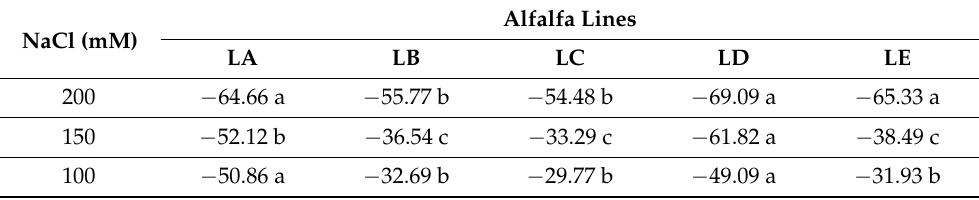
Table 1. Indexes of salt sensitivity (IS) estimated based on the total fresh biomass of five alfalfa lines grown for 10 weeks on a basal medium enriched with different salt concentrations. Data represent the average of 20 replicates.